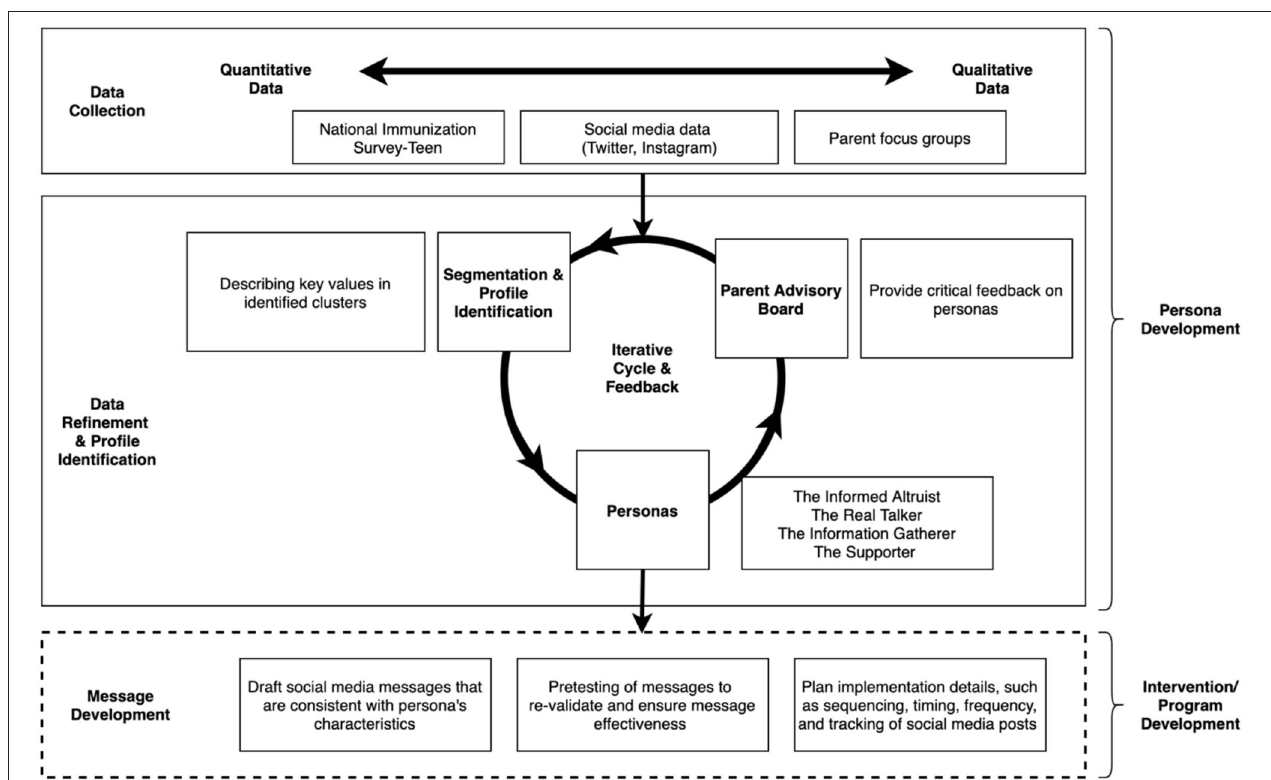
FIGURE 1 | Process used for persona development, including data collection, data refinement, and profile identification